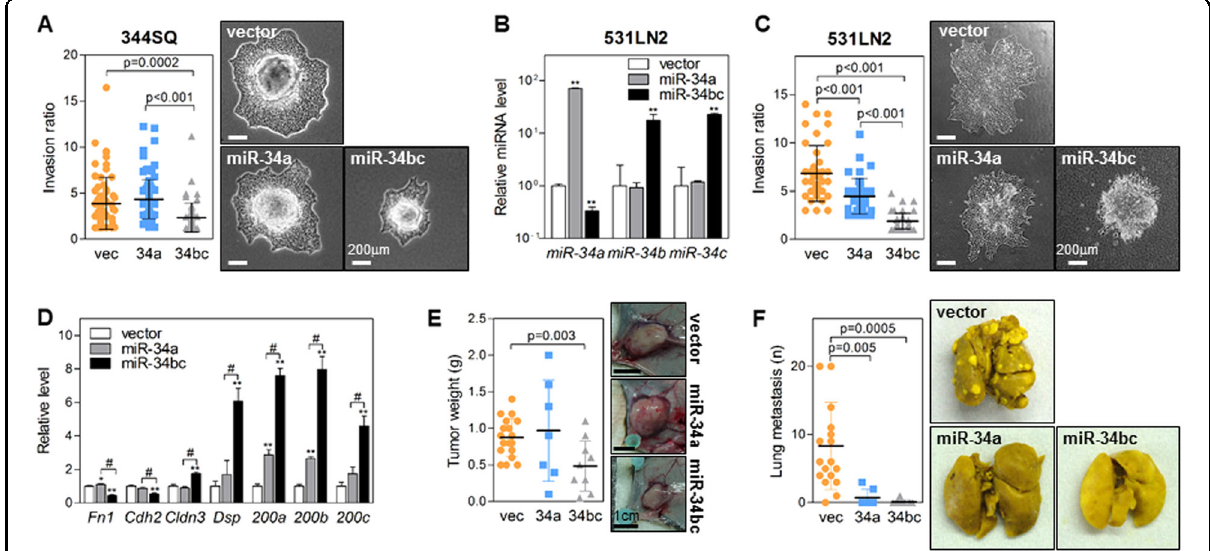
Fig. 4 MiR-34b/c inhibits invasion and EMT more effectively than miR-34a. a Spheroid invasion assay in miR-34-transduced 344SQ cells. Spheroids were seeded on collagen gels and then cultured for 48 h. Data are expressed as the mean ± SD (vec, n = 67; 34a, n = 96; 34bc, n = 59). P - values were determined using the two-tailed Student ’ s t test. b qRT-PCR of miR-34 family members in miR-34-transduced 531LN2 cells. Expression levels were normalized to the RNU6B snoRNA level, and the values relative to those of the 531LN2-vector (set at 1.0) are presented. Data are expressed as the mean ± SD ( n = 3). ** P ≤ 0.01; two-tailed Student ’ s t test. c Spheroid invasion assay in miR-34-transduced 531LN2 cells. Spheroids were seeded on collagen gels and then cultured for 48 h. Data are expressed as the mean ± SD (vec, n = 41; 34a, n = 41; 34bc, n = 58). P -values were determined using two-tailed Student ’ s t test. d qRT-PCR of EMT markers ( Fn1 and Cdh2 : epithelial, Cldn3 and Dsp : mesenchymal markers) and miR-200 family members (miR-200a, miR-200b, and miR-200c) in miR-34-transduced 344SQ cells. Expression levels were normalized to Rpl32 (for mRNA) or RNU6B snoRNA (for miRNA) levels. The values relative to those of the 344SQ vector (set at 1.0) are presented. Data are expressed as the mean ± SD ( n = 3). * P ≤ 0.05, ** P ≤ 0.01 compared with vector and # P ≤ 0.01 compared with miR-34a cells; two-tailed Student ’ s t test. e , f Primary tumor weight ( e ) and number of lung metastases ( f ) in syngeneic mice (129/Sv) injected subcutaneously with miR-34-transduced 344SQ cells (1 × 10 6 cells per mouse). Lungs were stained with Bouin ’ s solution to visualize the metastatic tumor nodules. Data are expressed as the mean ± SD (vec, n = 19; 34a, n = 7; 34bc, n = 10). P -values were determined using two-tailed Student ’ s t